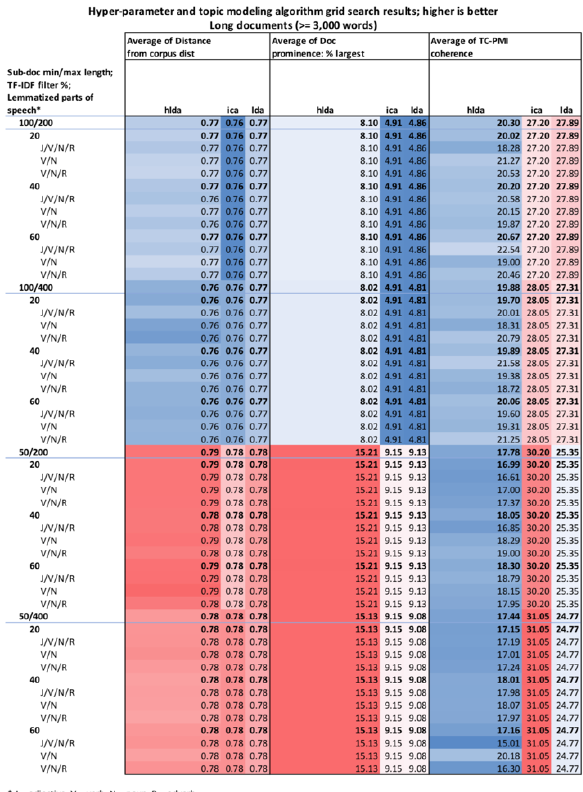
Figure 14. Hyper-parameter testing results, long